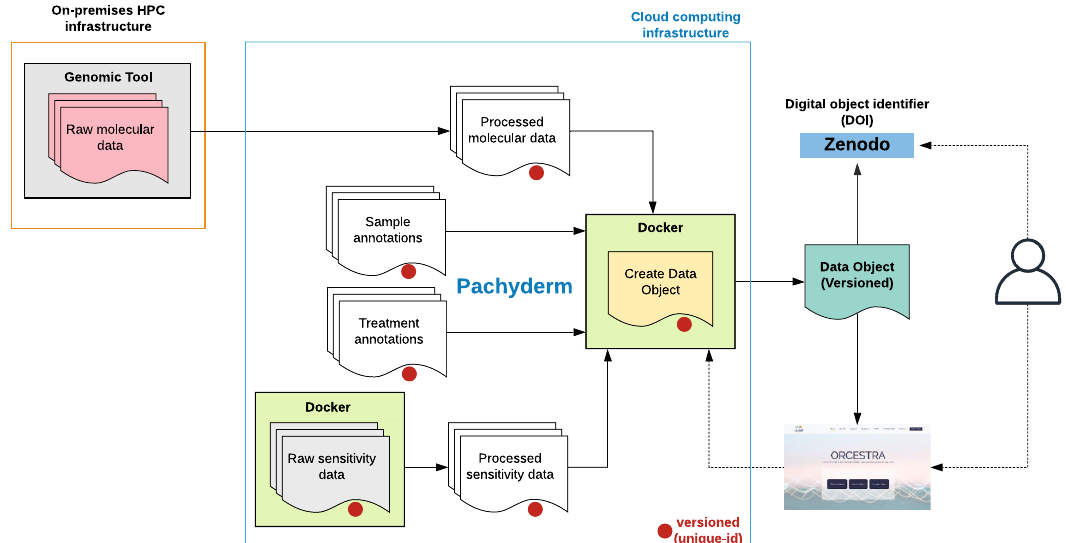
Fig. 4 The Cloud-based deployment of the ORCESTRA data-processing layer automatically versions data using Pachyderm and shares generated data objects through Zenodo via a persistent identi fi er (DOI). Each fi le and pipeline in the Pachyderm environment are provided a unique identi fi er, allowing for each data object to be